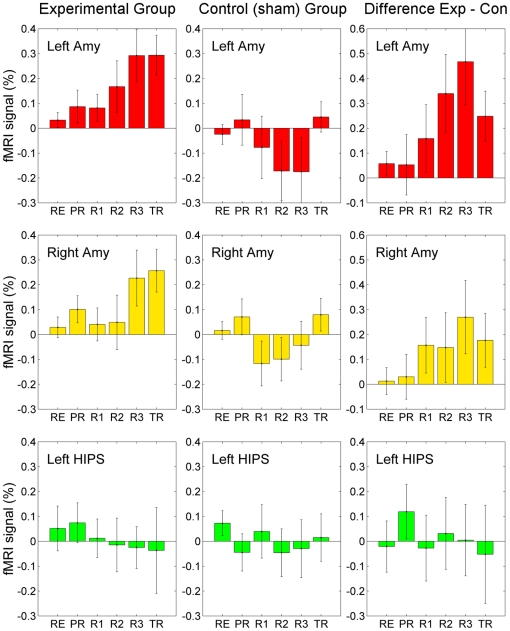
Learned Enhancement of Control over BOLD fMRI Activation and Mood Induction.A significant training effect was observed for the left amygdala for the subjects in the experimental group. The control of BOLD fMRI activation in the left amygdala ROI monotonically increased over training runs and persisted during the Transfer run. Each bar represents mean percent signal change in the BOLD signal (± s.e.m.) averaged across Happy Memories conditions during a given run (see text for details) for each ROI (left amygdala, red; right amygdala, yellow; left HIPS, green) and group (experimental, control). The difference between the corresponding average fMRI percent signal change values for the experimental and control (sham) groups is also shown.